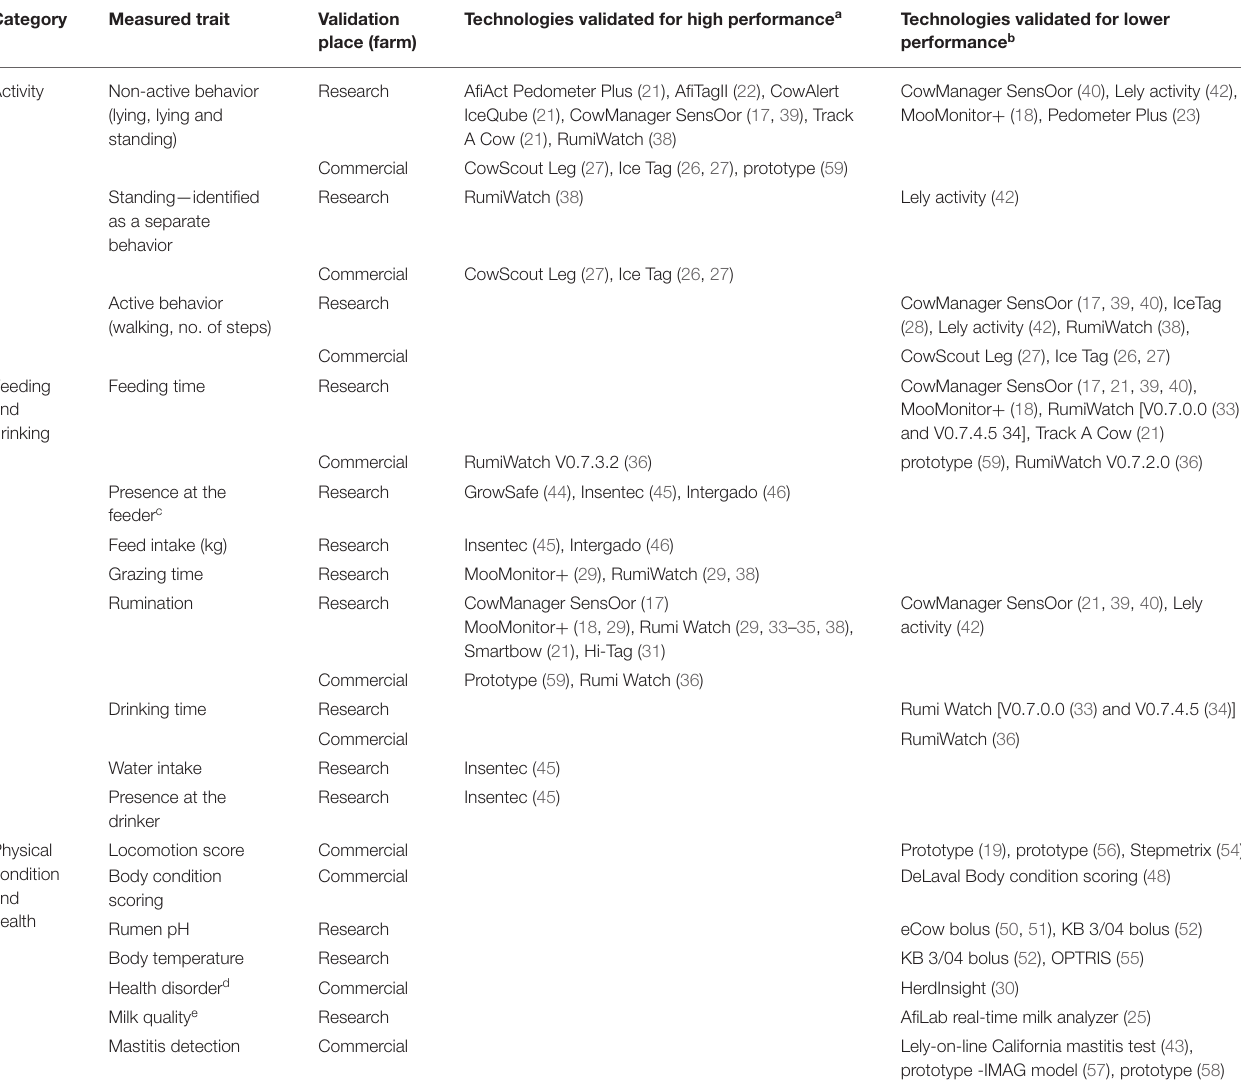
TABLE 2 | Results of validation trials for dairy cows in respect to measured traits.